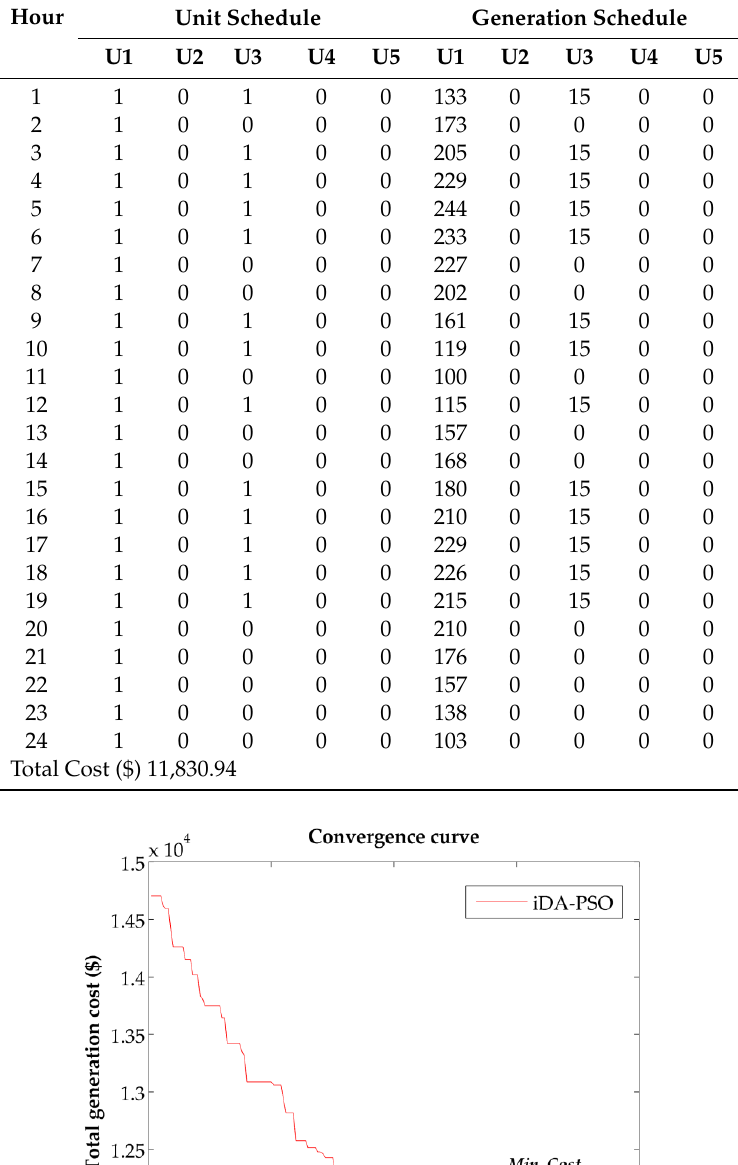
Table 9. Commitment and generation schedule of the 5-unit system by Improve Dragonfly Algorithm- Particle Swarm Optimization (iDA-PSO) approach.